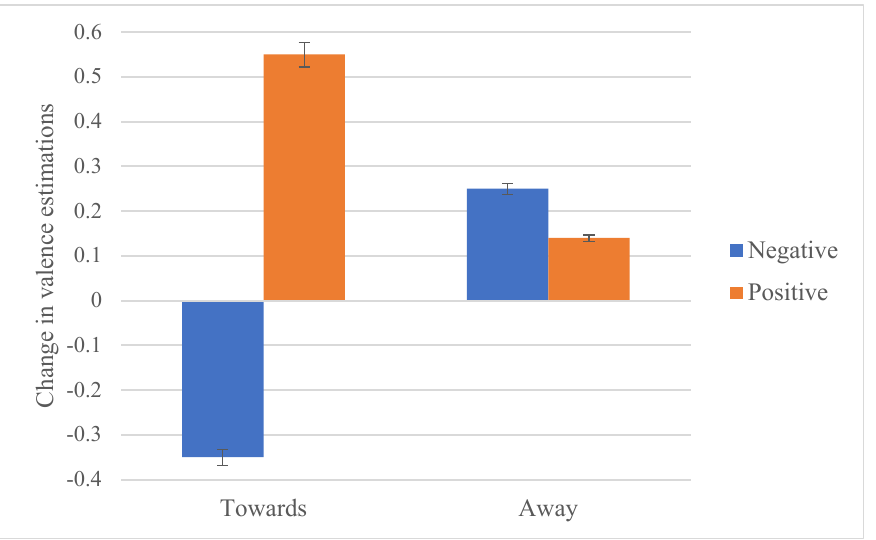
Figure 2. Swiping positive pictures towards or negative ones away positively changed the valence estimation. Vertical bars indicate 95% confidence intervals adjusted for baseline.